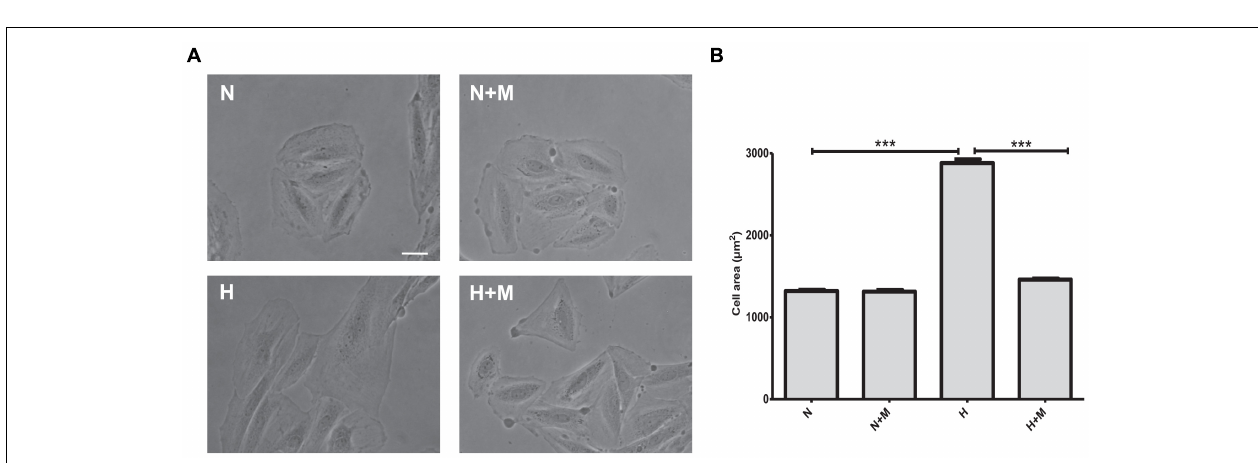
FIGURE 2 | Metformin prevents hypoxia-induced cell hypertrophy. (A) Representative images of H9C2 cells subjected to normoxia (N) or hypoxia (H) for 24 h in the presence or absence of 5 mM metformin (M). (B) Quantification of cell area from (A). Scale bar is 100 µ m. Data represents the mean ± SEM from at least three independent experiments. Statistical analysis was carried out by one-way ANOVA: ∗∗∗ P < 0.001 between indicated conditions.